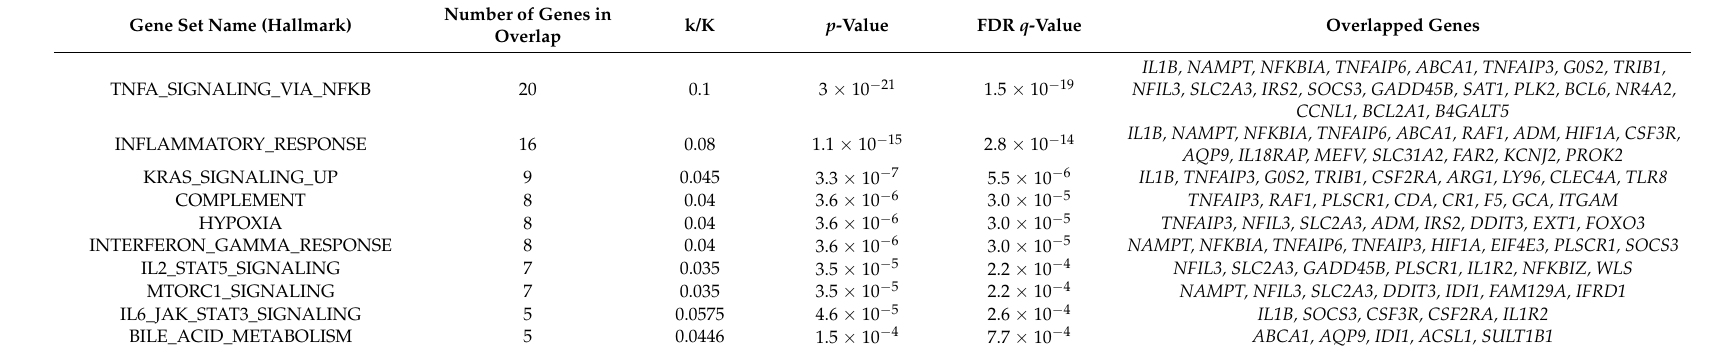
Table 2. Enriched cellular hallmarks in MCSP CTC fractions from metastatic melanoma cases.